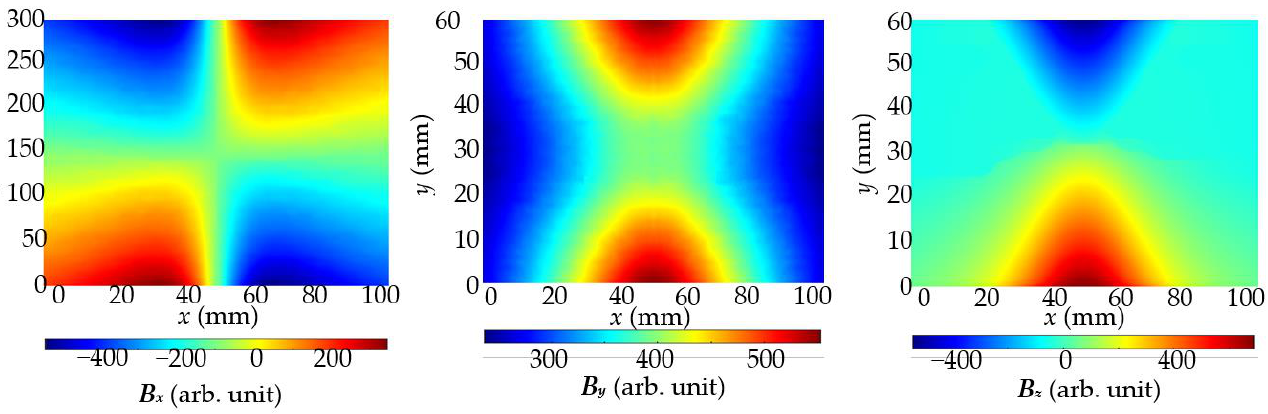
Figure 12. Magnetic field B x , B y , and B z components measured in case of the same pole polarization and sample S1 with single rebar. Measurements were carried out with the AMR sensor; concrete cover thickness h = 20 mm.